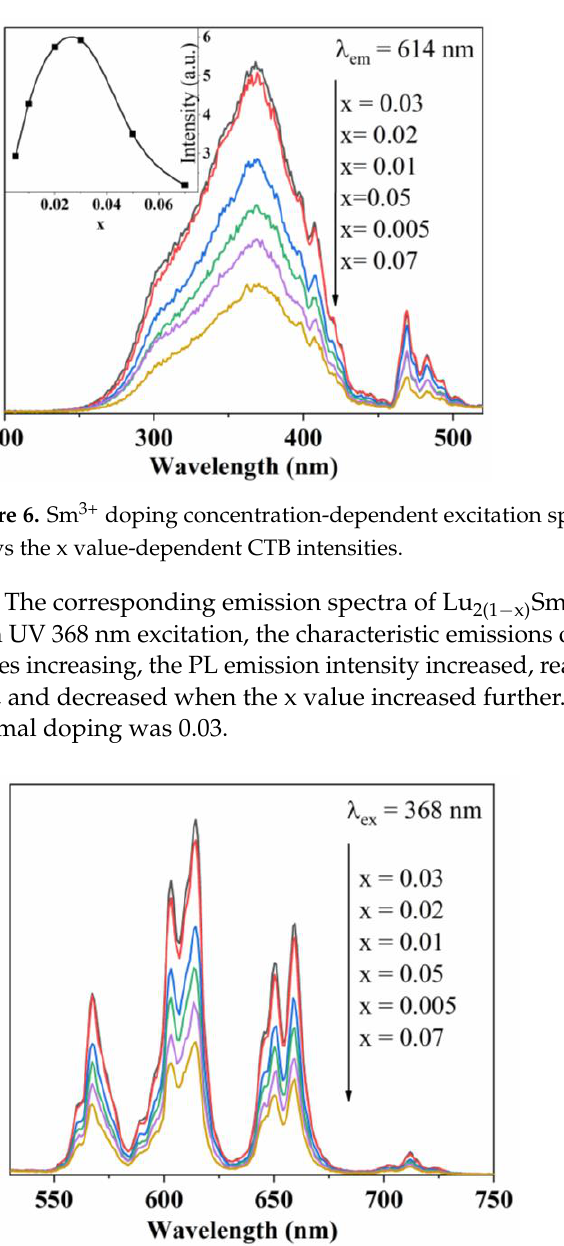
Figure 7. Sm 3+ concentration dependent PL emission spectra of Lu 2(1 − x) Sm 2x MoWO 9 .